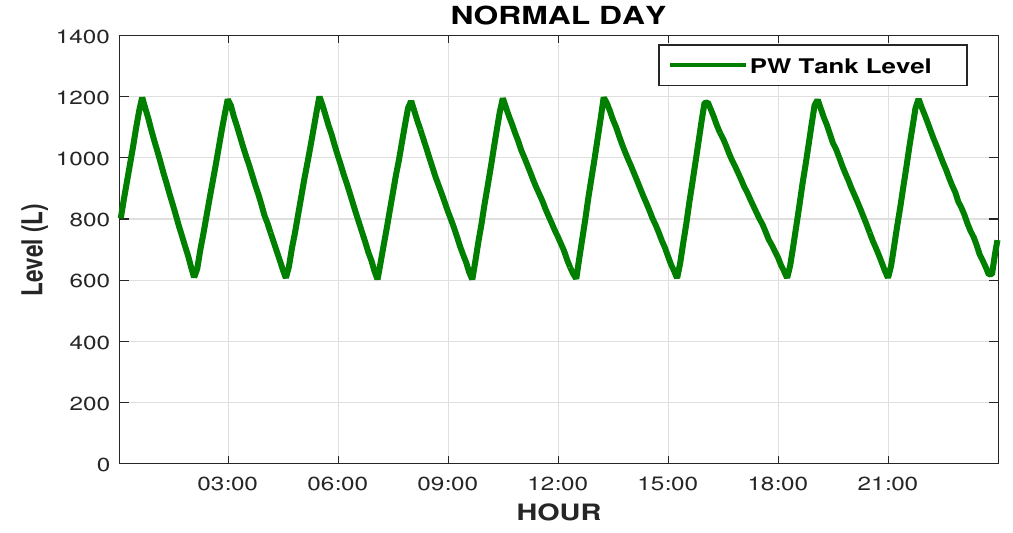
Figure 15. Sketch of the PW tank level reading